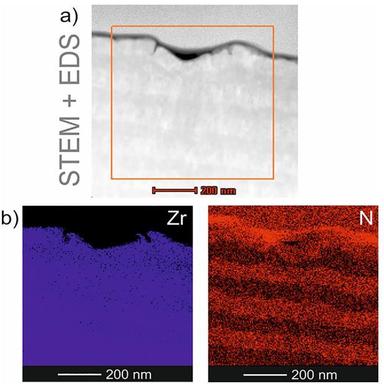
Qualitative chemical analysis of the Zr/Zr2N (1:1 ratio) multilayer coating that was conducted in the region of anodic dissolution by EDS; a) STEM image marked with the region of analysis; and b) maps of selected element distribution.